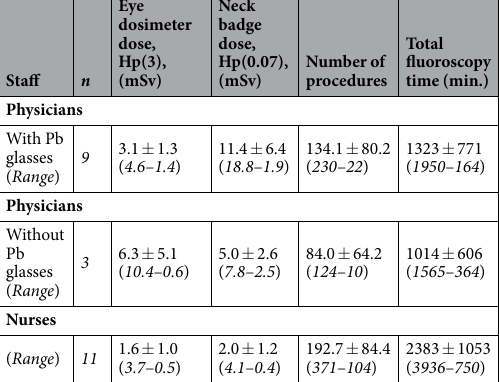
Table 1. Summary of our 6-month study. mean ± SD.